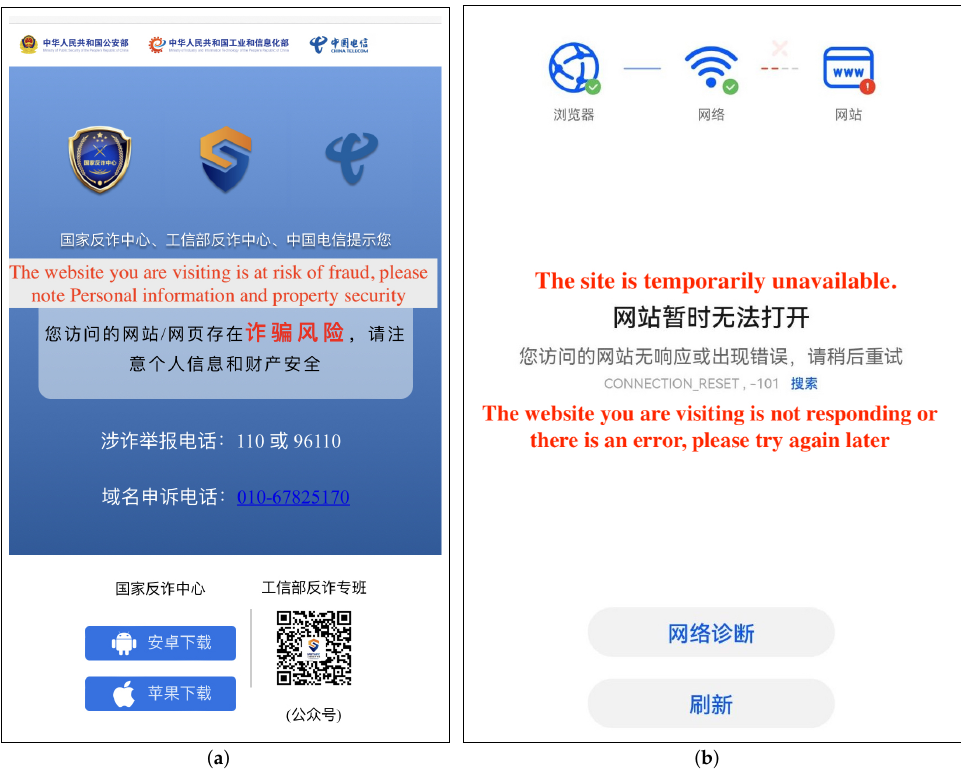
Figure 7. ISPs handle abusive domains. ( a ) Users of ISP China Telecom in Weihai, Shandong province browse the gambling domain name j***j.com. ( b ) Users of ISP China Mobile in Weihai, Shandong province browse the porn domain name 6*****r.com.